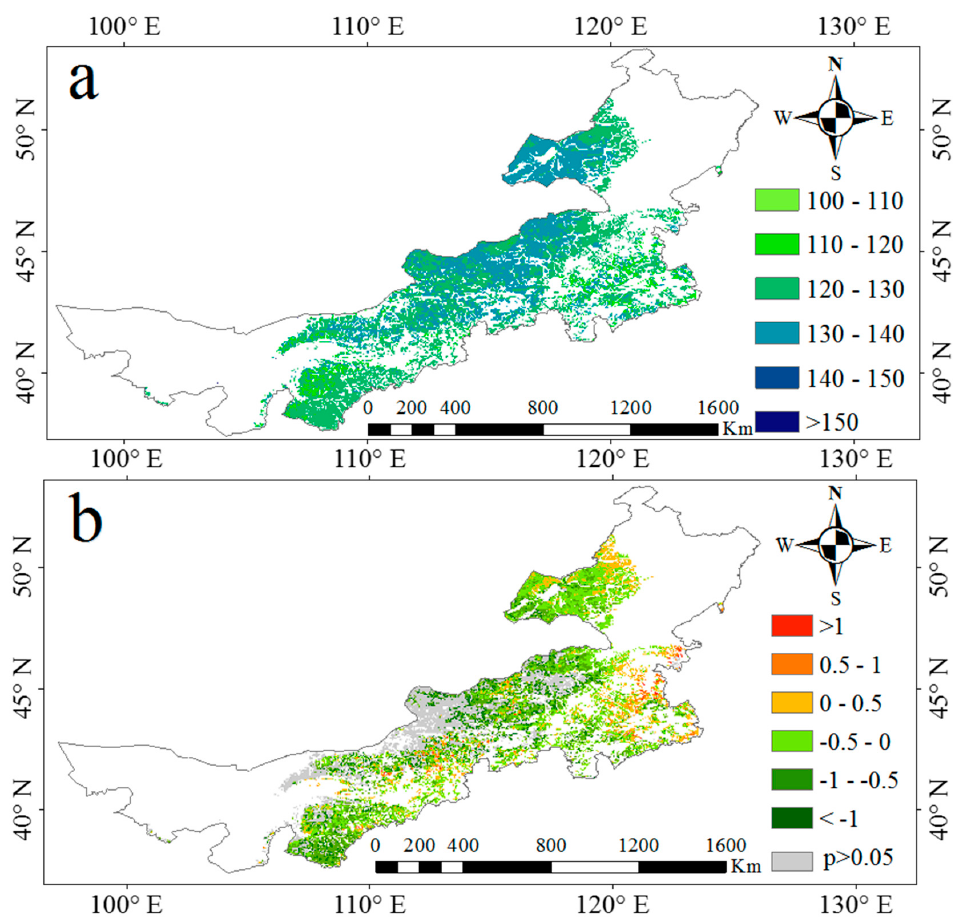
Figure 3. ( a ) Spatial distribution of the mean SOS in the grassland of Inner Mongolia during 1982–2015; ( b ) spatial distribution of the change trend for SOS in the grassland of Inner Mongolia during 1982–2015. The SOS change trends are termed significant for pixels at p < 0.05 level.